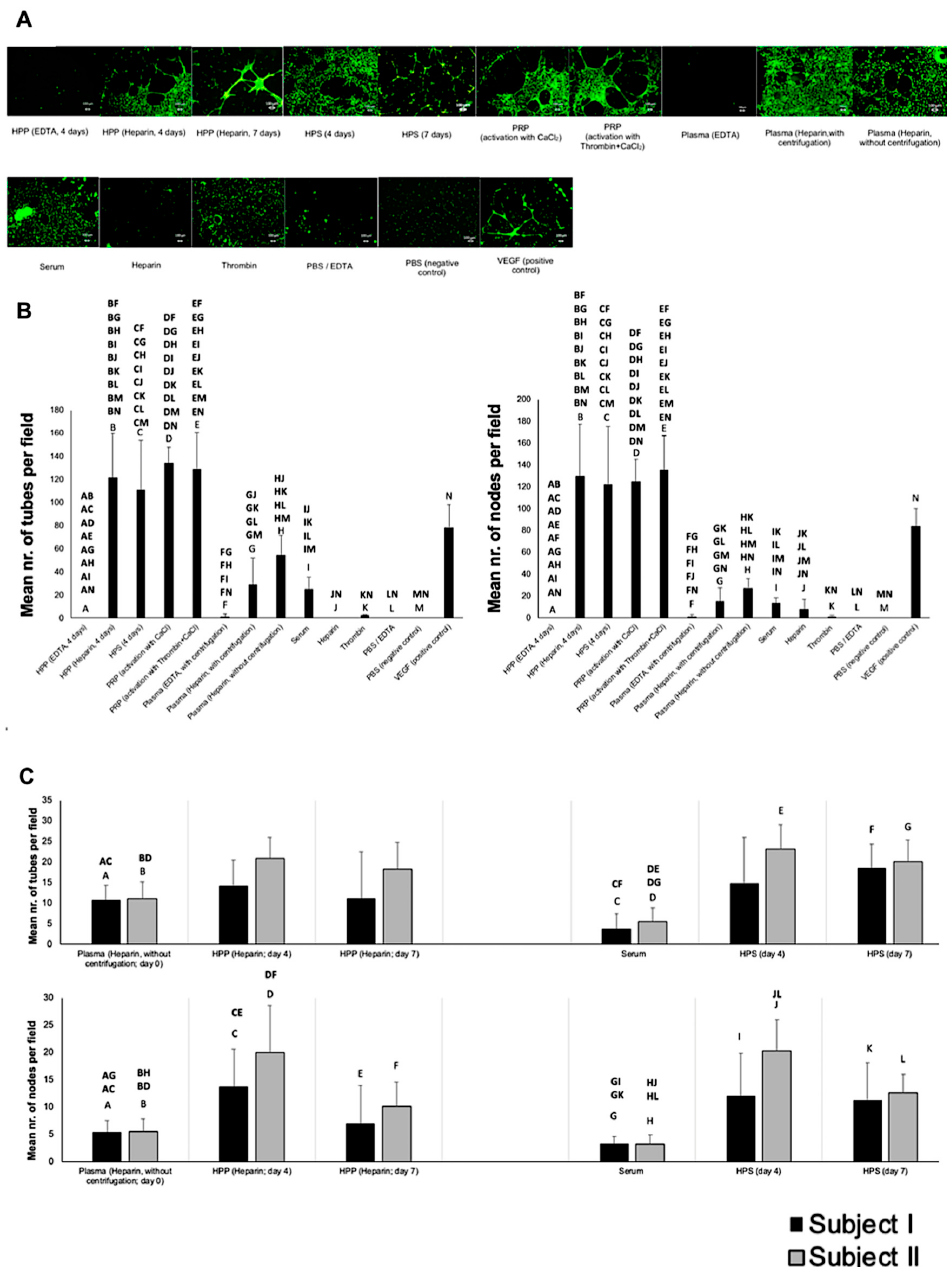
Figure 3. E ff ect of blood-derived secretomes on microvessel formation in human umbilical vein endothelial cell (HUVEC) cultures in vitro. ( A ) Panel showing representative images of the tube formation assay (12 h), carried out in the presence of the shown blood-derived secretomes (Bars = 100 µ m). ( B ) Plot showing the mean number of tubes (left) and nodes (right) formed in di ff erent blood-derived secretome cultures ( n = 5). ( C ) E ff ect of blood incubation time (4 and 7 days) on the angiogenic activity of hypoxia preconditioned secretomes. Plot showing the mean number of tubes (top) and nodes (bottom) formed in 4 and 7 days incubated -HPP and -HPS cultures, with blood obtained from two subjects ( n = 3 per subject). Capital letter pairs over plots indicate statistical comparison of corresponding data points. For all pair comparisons p < 0.05, unless otherwise indicated. Error bars represent s.d.